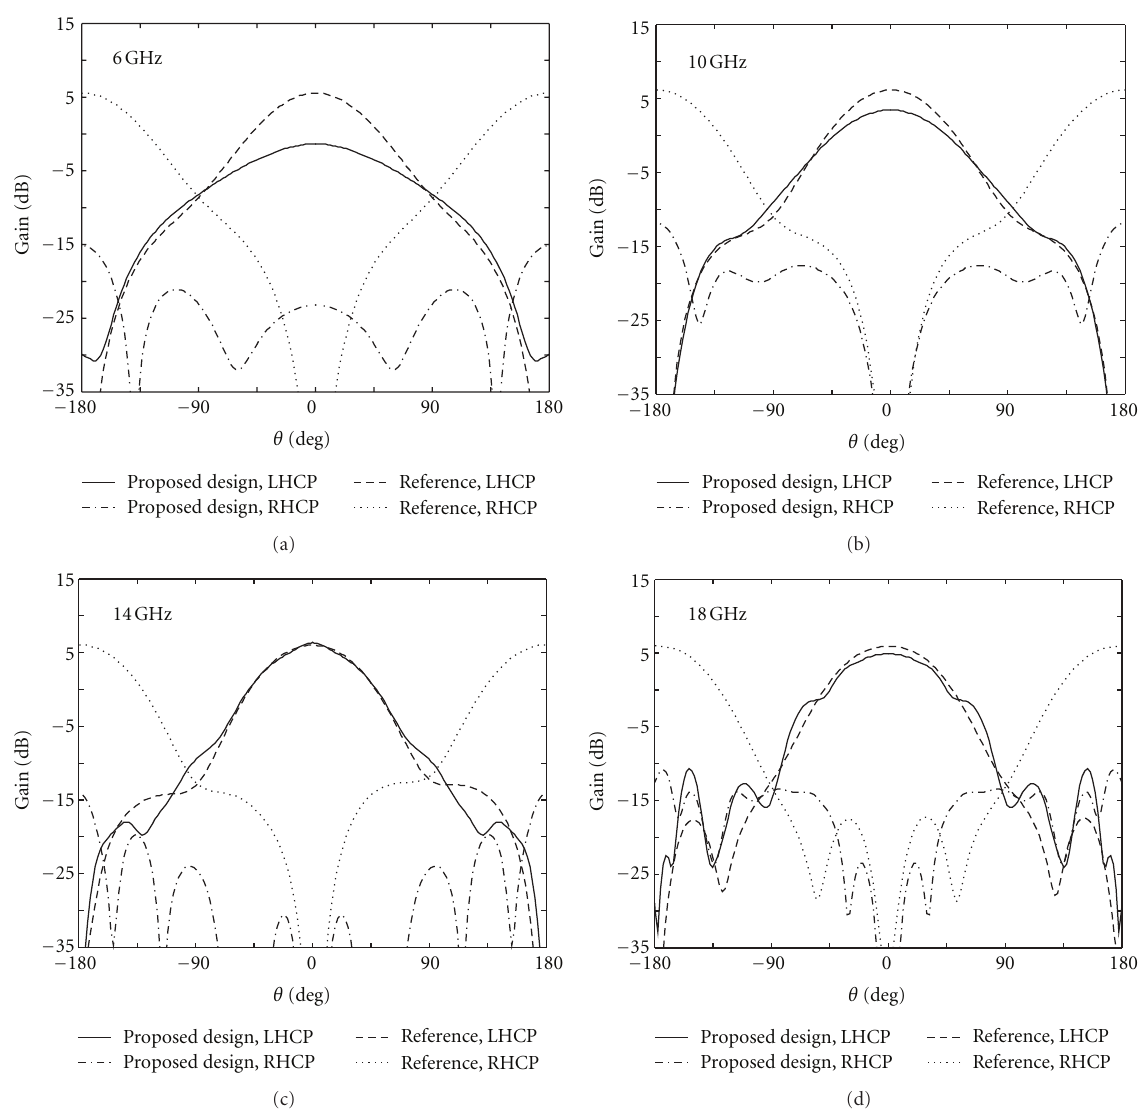
Figure 3: Simulated Gain diagrams of the structure backed with lossy concentric dielectric cylinders, at φ = 0 compared to the free space sinuous.